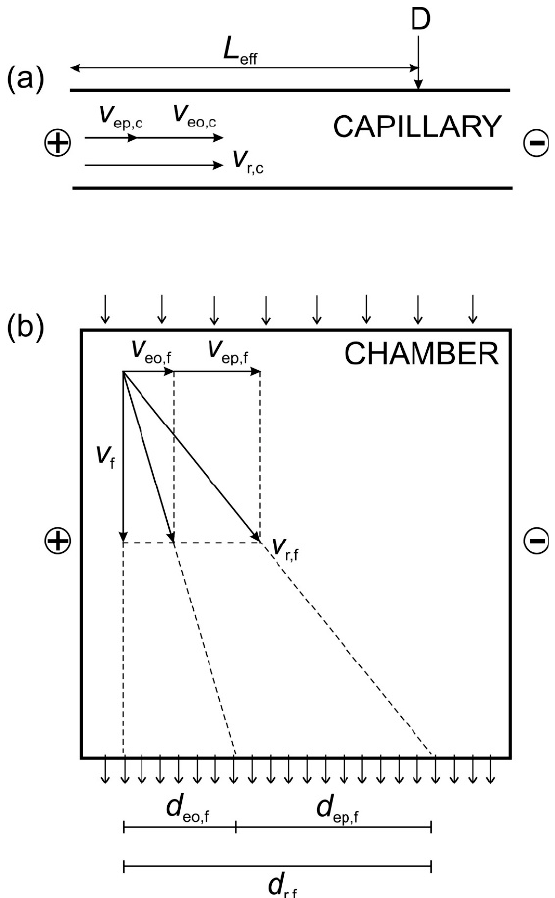
Figure 3. Superposition of the migration velocities in CZE ( a ) and FFZE ( b ); L eff , effective length of the capillary; D, detection position; v ep,c , electrophoretic velocity in CZE; v eo,c , electroosmotic velocity in CZE; v r,c , resulting migration velocity in CZE; v ep,f , electrophoretic velocity in FFZE; v eo,f , electroosmotic velocity in FFZE; v f , hydrodynamic flow velocity in FFZE; v r,f , resulting migration velocity in FFZE; d eo,f , electroosmotically migrated distance in FFZE; d ep,f , electrophoretically migrated distance in FFZE; d r,f , resulting migration distance in FFZE.